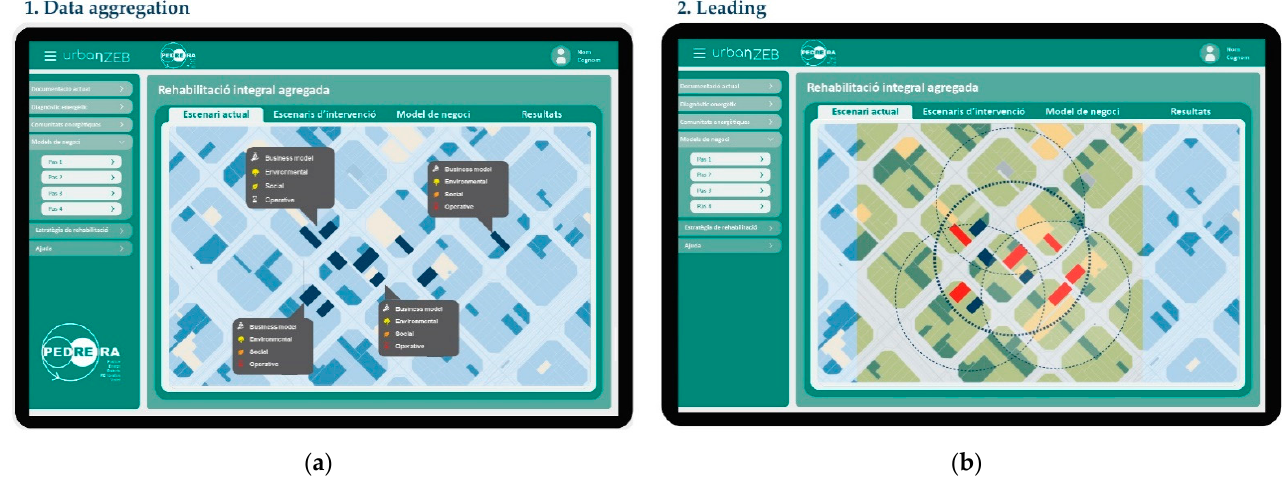
Figure 3. Extract of the PEDRERA model approach expected visualization in the urbanZEB tool: ( a ) Data aggregation at urban level; ( b ) leading phase and stakeholder engagement for the cluster of building selection. Source: authors.